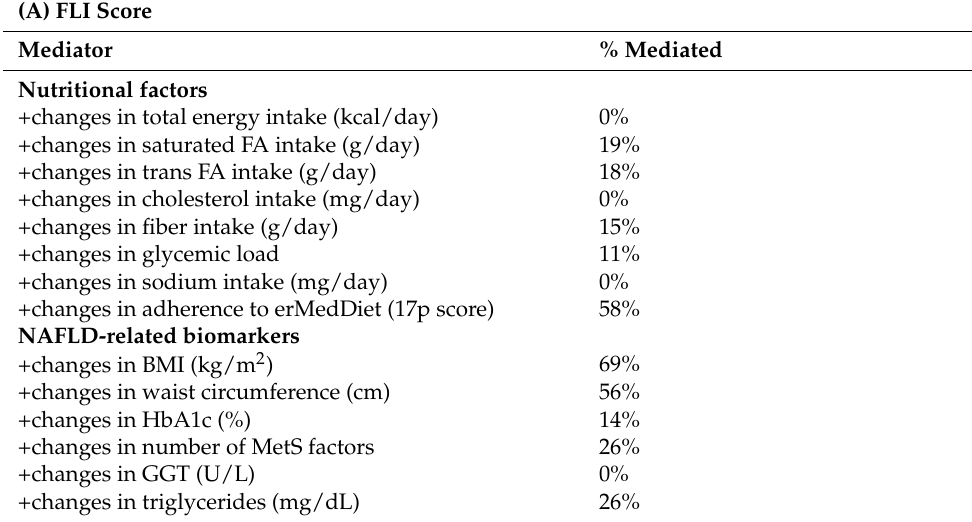
Table 3. Proportion of the association between concurrent changes in UPF consumption (% of g/day, continuous variable) and changes in NAFLD indices during 1 year of follow-up mediated through nutritional factors and NAFLD-related biomarkers (fully adjusted model